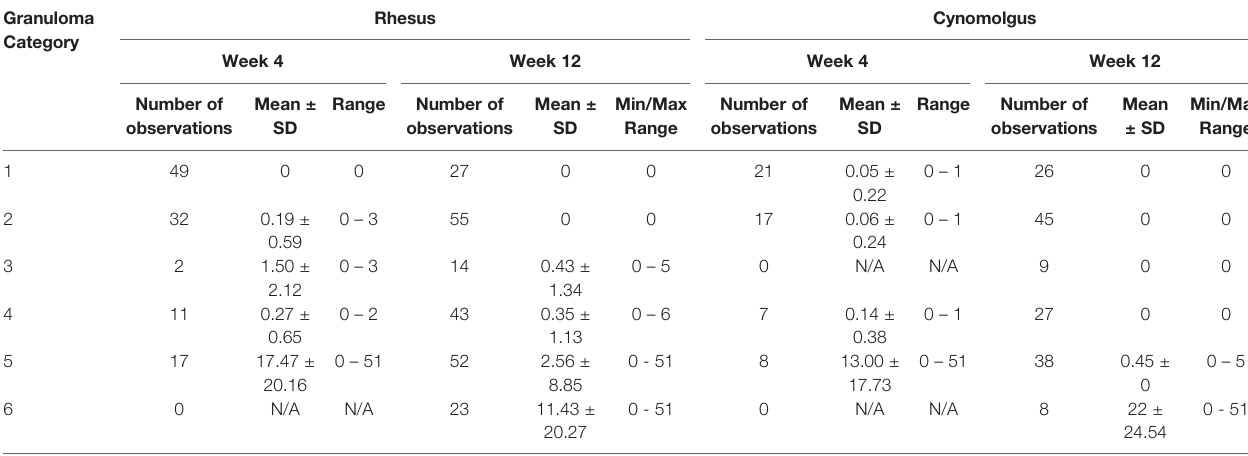
TABLE 3 | Descriptive statistics of acid-fast bacilli counts for each category of granuloma stage. Granuloma Category